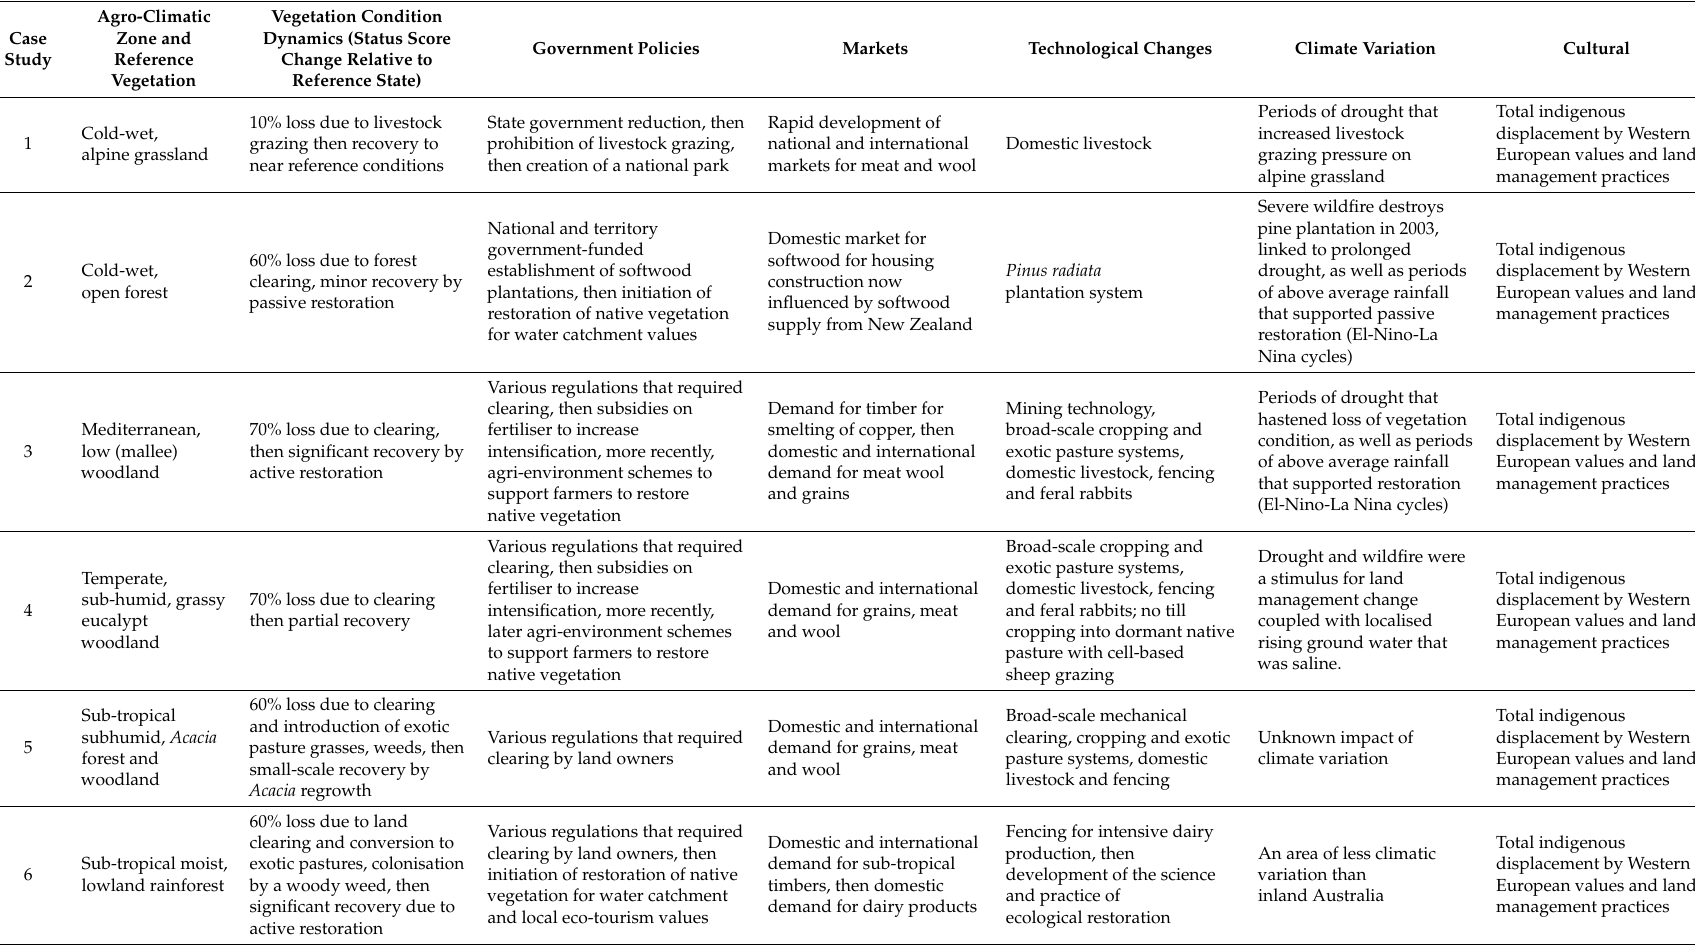
Table 3. Drivers of changes in vegetation conditions across representative case studies from Australia’s ago-climatic zones based on Figures 2–11 and case study descriptions provided in Tables S1 and S2 in the Supplementary